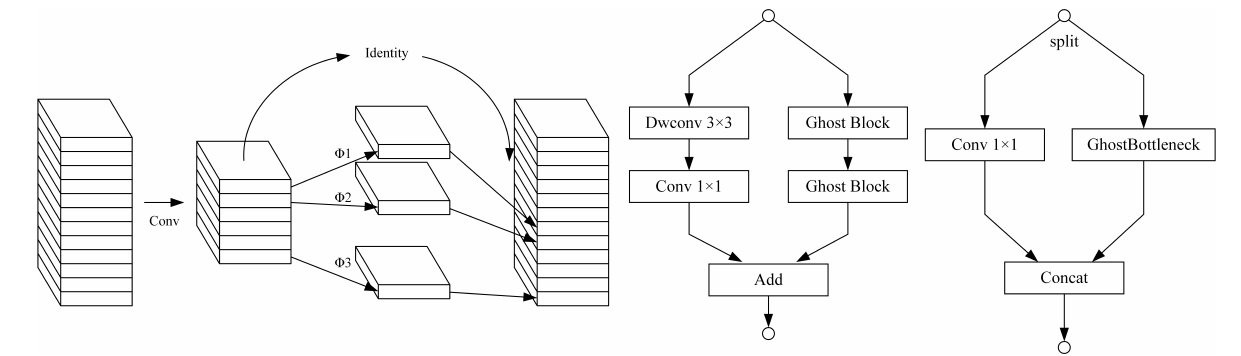
Figure 7. The structure of the L-PAFPN components.